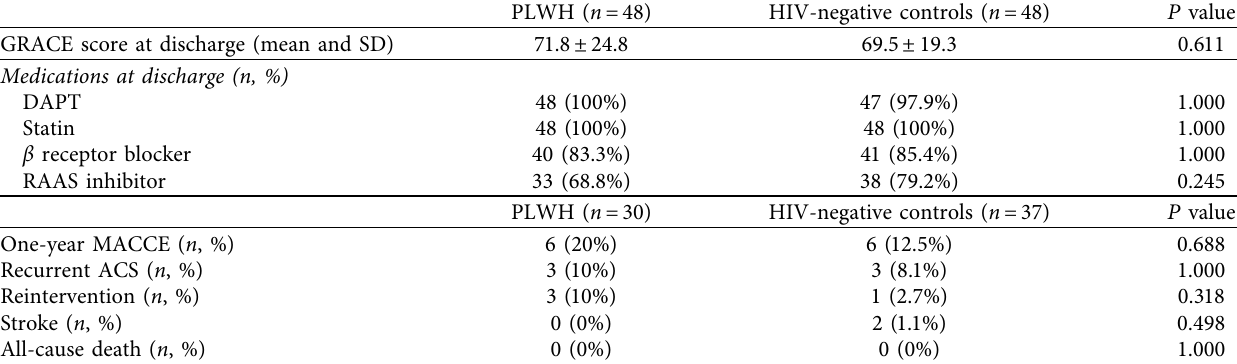
Table 4: GRACE score and medications at discharge and the one-year MACCE incidence.